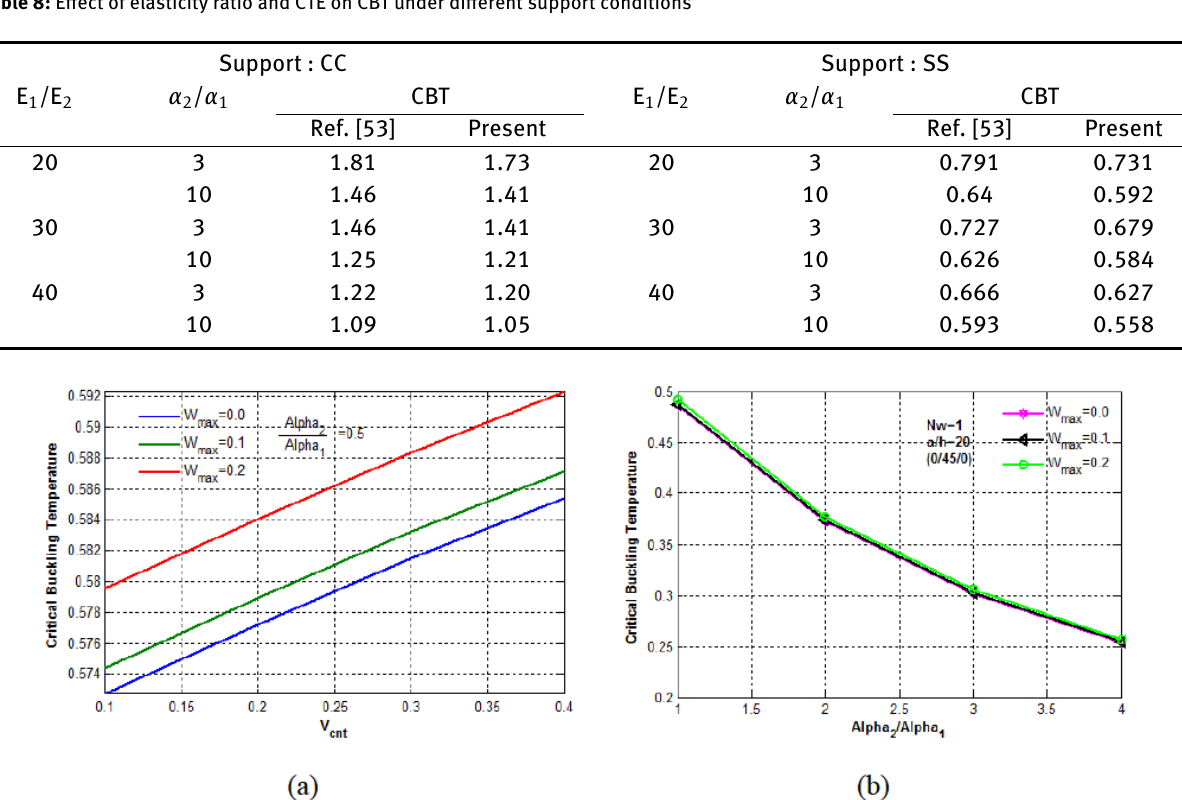
Figure 8: Influence of (a) SWCNT volume fraction and (b) ratio of CTE on